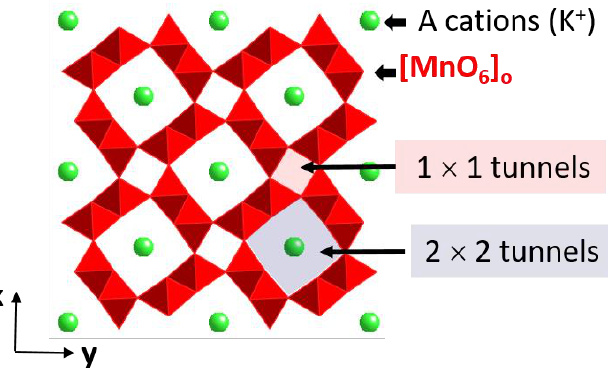
Figure 6. Schematic representation of the hollandite structure.